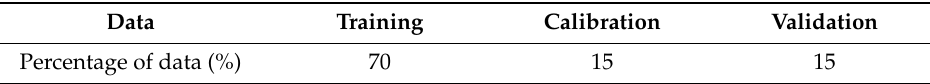
Table 4. Original data partitioning.